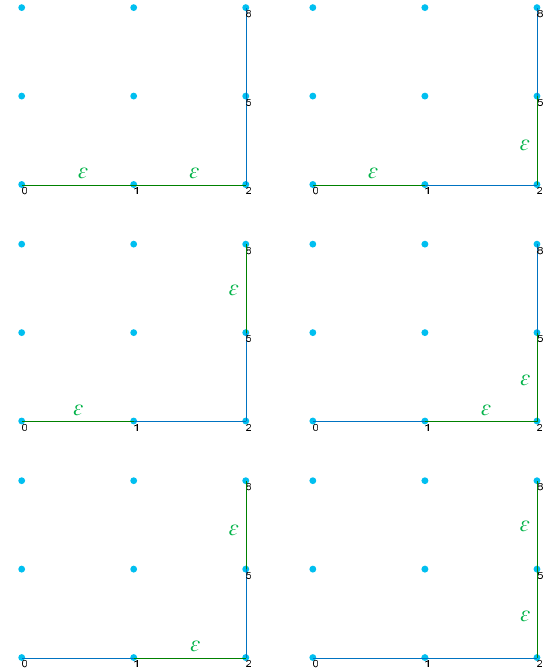
Figure 8. All the length-2 sub-paths of the path [0 1 2 5